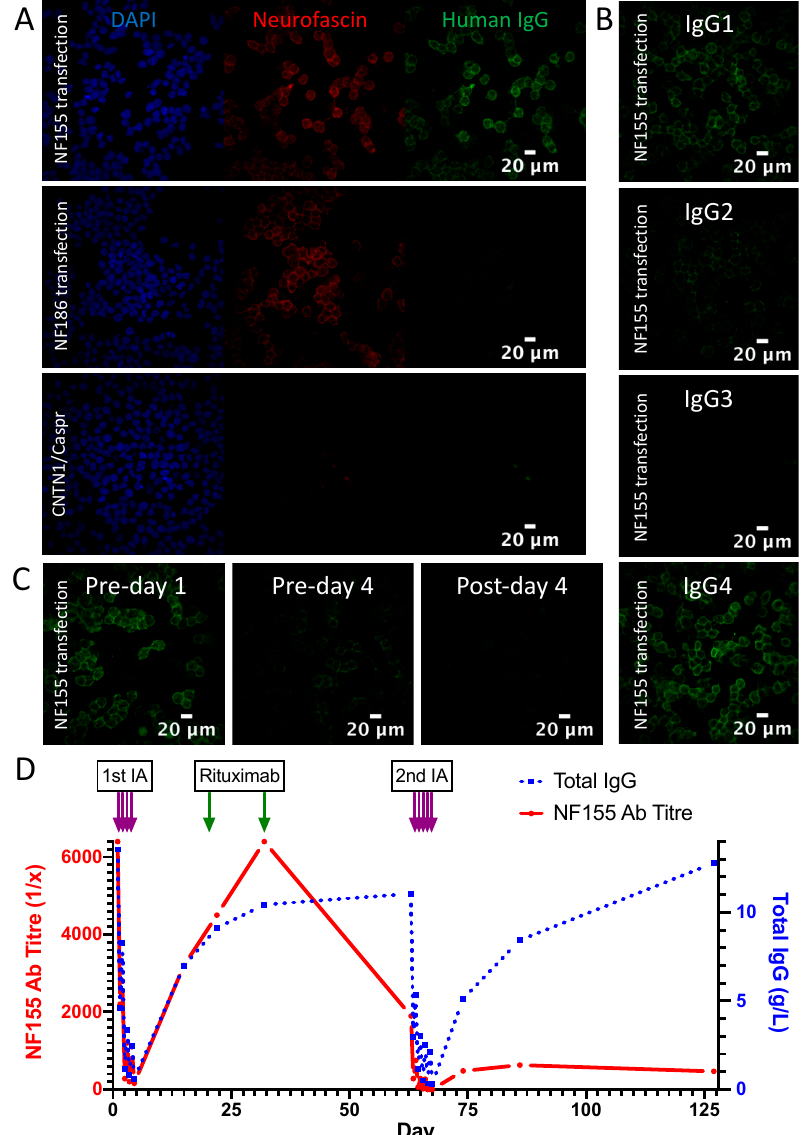
Figure 2. Serological results of NF155 antibody positive patient at baseline and during IA treatment. ( A ) Serum contains IgG (green) which binds to the cell membrane of NF155-transfected HEK293T cells, and co-localises with a commercial pan-neurofascin antibody (red). No signal is seen with NF186 or CNTN1/Caspr1-transfected cells. ( B ) The predominant IgG subclass of the NF155 antibodies is IgG4, with IgG1>IgG2 also represented. ( C ) The antibody signal intensity at 1:100 before, during and immediately after the first cycle of IA shows a progressive decline. ( D ) NF155 antibody titre (red) and total IgG levels (blue) over 2 cycles of IA, before and after rituximab.